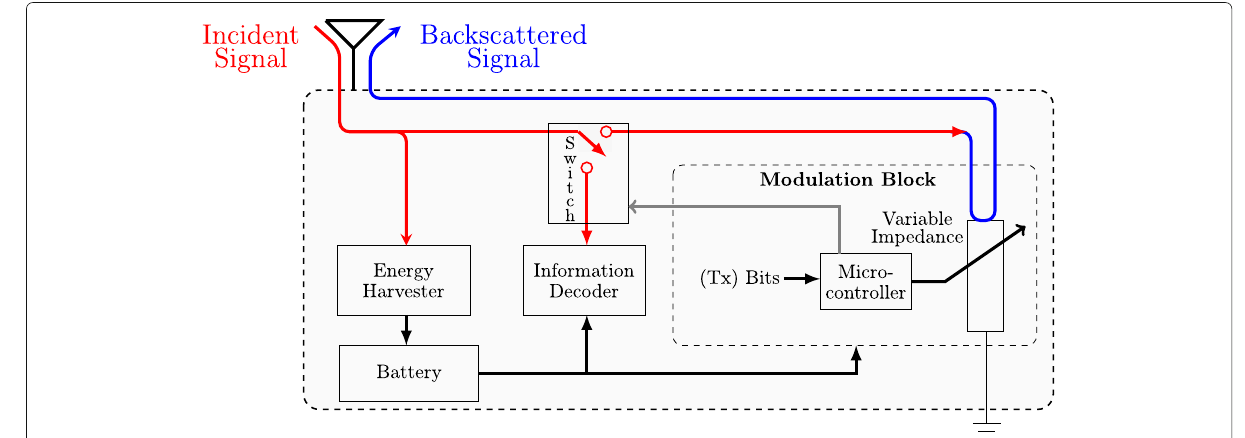
Fig. 1 The architecture of a backscatter tag